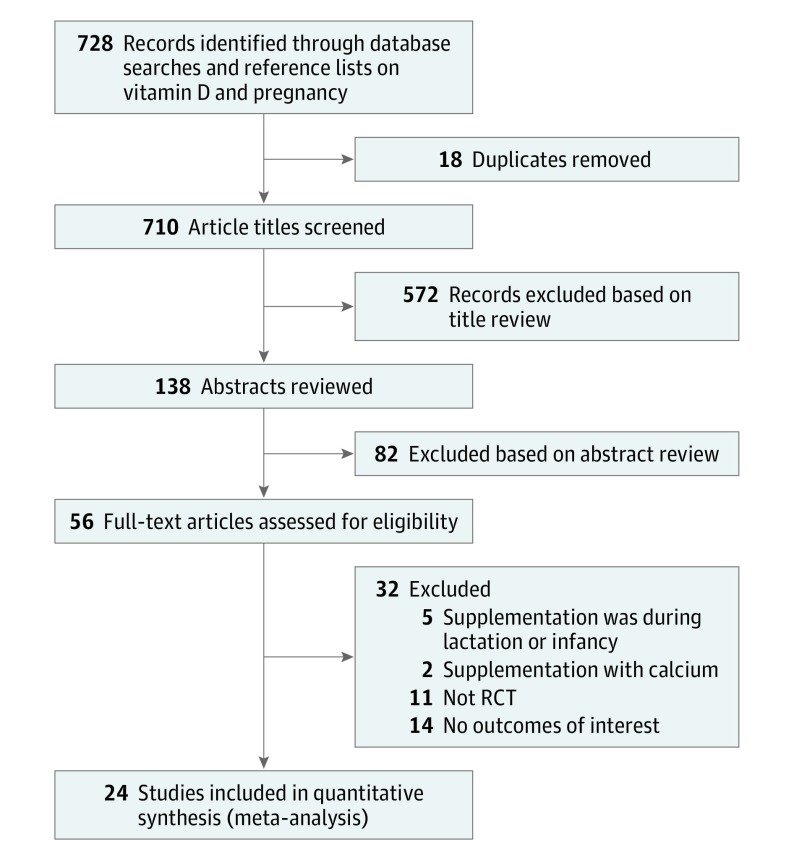
Flowchart of Study Selection ProcessRCT indicates randomized clinical trial.